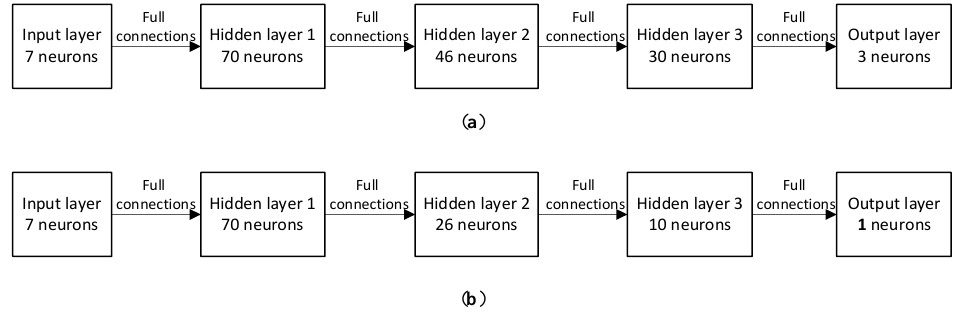
Figure 4. Actor – critic network structure. ( a ) Structure of policy network; ( b ) structure of critic net- work.